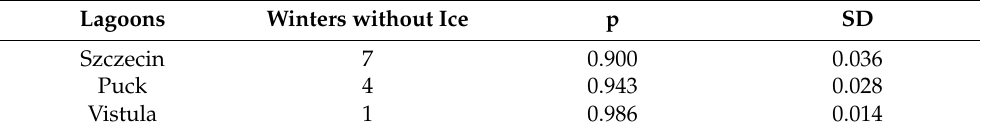
Table 3. Probability of ice (p) and its standard deviation (SD) in southern Baltic coastal lagoons (1950/51–2019/20).